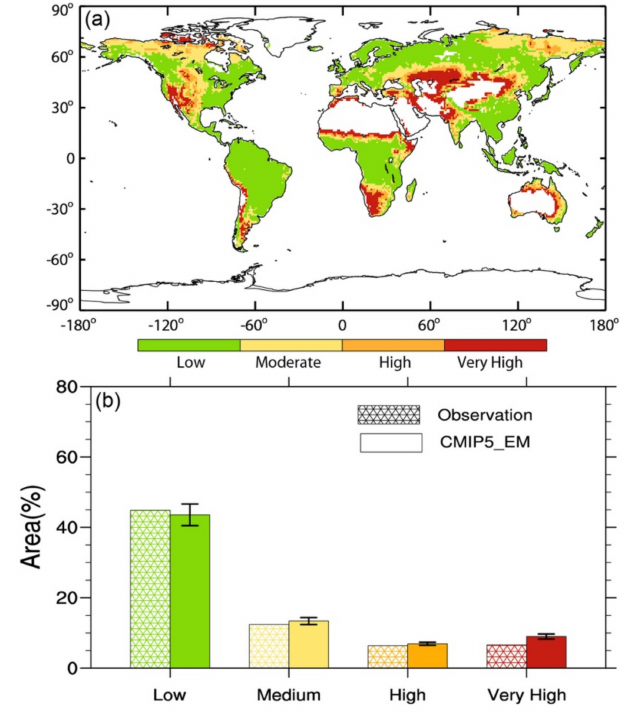
Figure 2. ( a ) The global desertification risk level distribution from 2000 to 2014, estimated based on the Global Desertification Vulnerability Index; ( b ) The proportion of areas with different desertification risk levels in the global land area